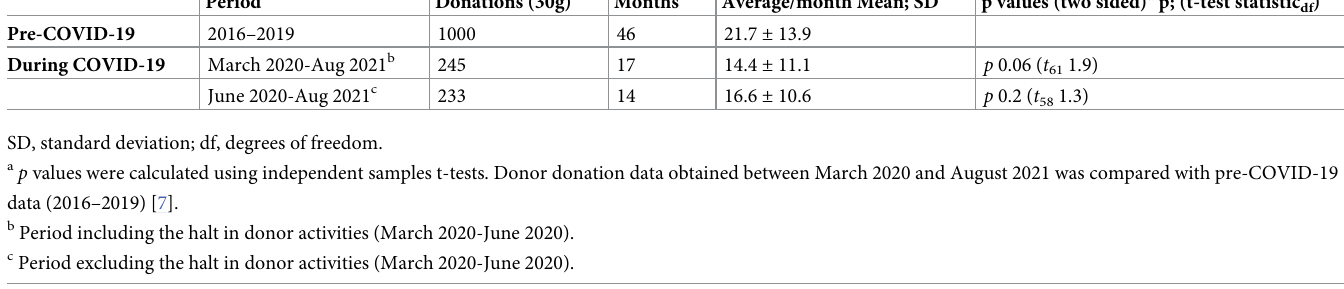
Table 1. Faeces donations (30 grams) during versus before the COVID-19 pandemic.